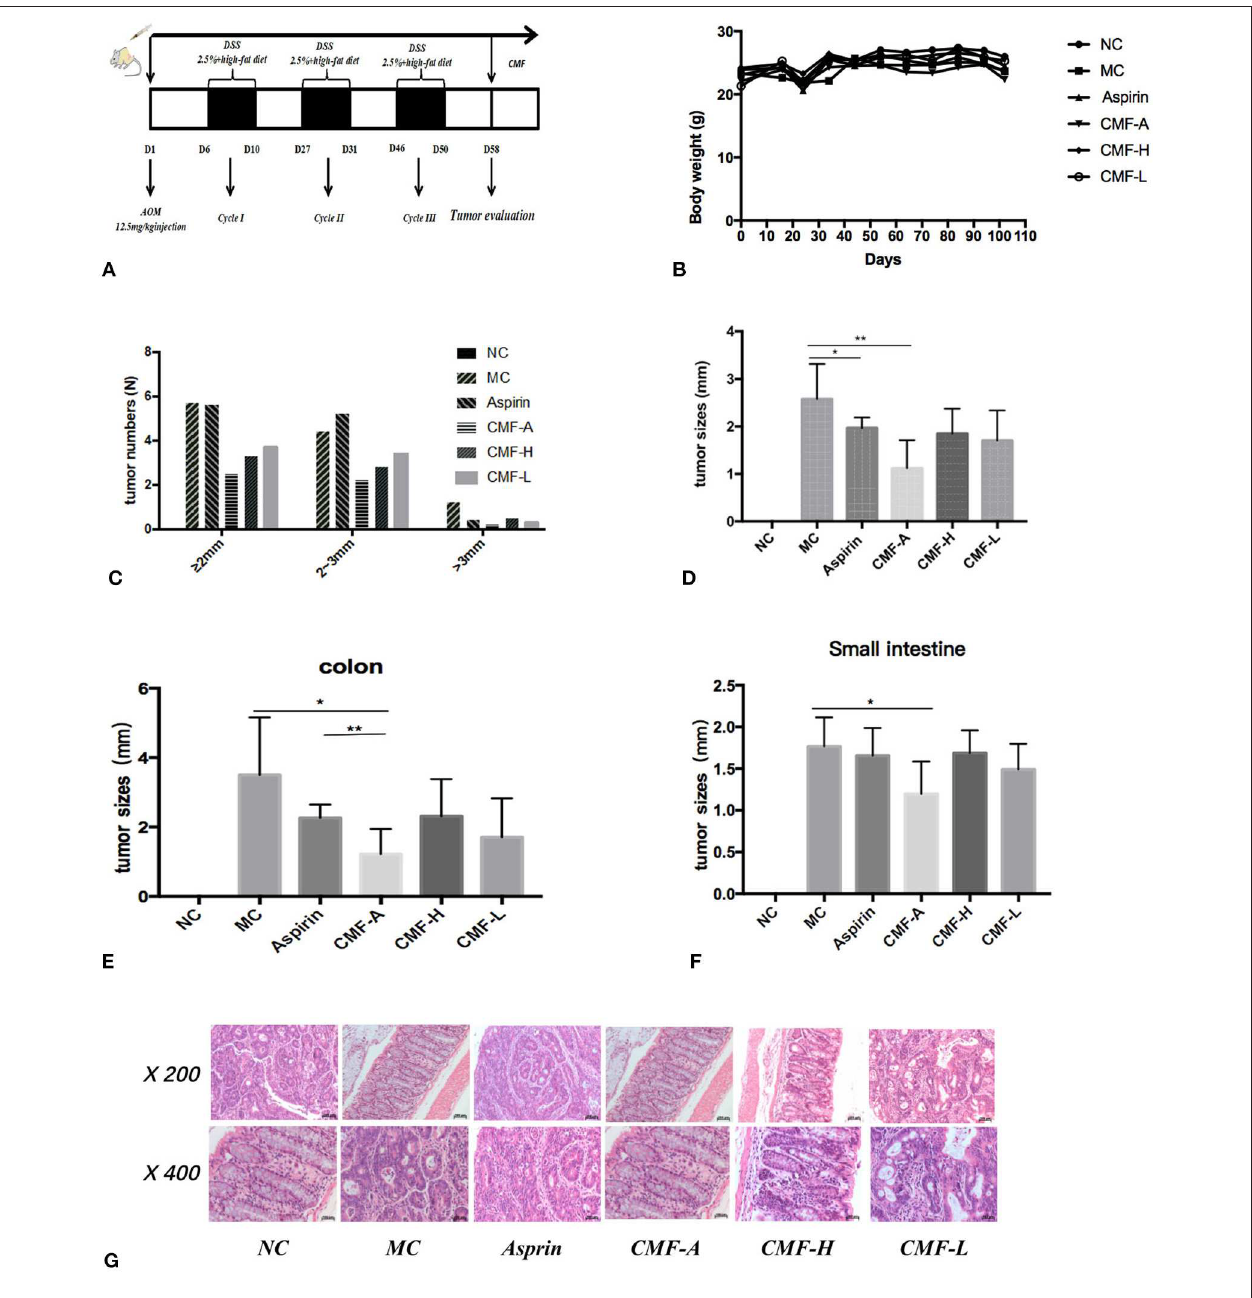
FIGURE 2 | CMF treatment reduced the incidence of CRA in mice. C57BL/6 mice were subjected to an AOM-based CRC induction protocol using three cycles of 2.5% DSS in drinking water. (A) Diagram shows the experimental course of AOM/DSS mouse model. (B) Body weights of AOM/DSS group and AOM/DSS + CMF group (1, 3, 4, 5, 6). (C) Histogram showing the size distribution of tumors. (D–F) Tumor sizes in different parts determined by Spot software for microscopic tumors or a caliper for macroscopic tumors. Average tumor size ± S.D. is shown; (G) H&E stains of serial sections of colons. * P < 0.05; ** P < 0.01. Data are presented as mean ± SD of mice in each